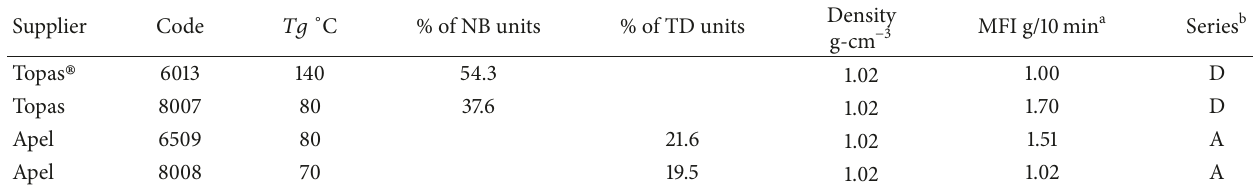
Table 1: Description and properties of cycloolefin copolymers used in this study (data provided by the suppliers).